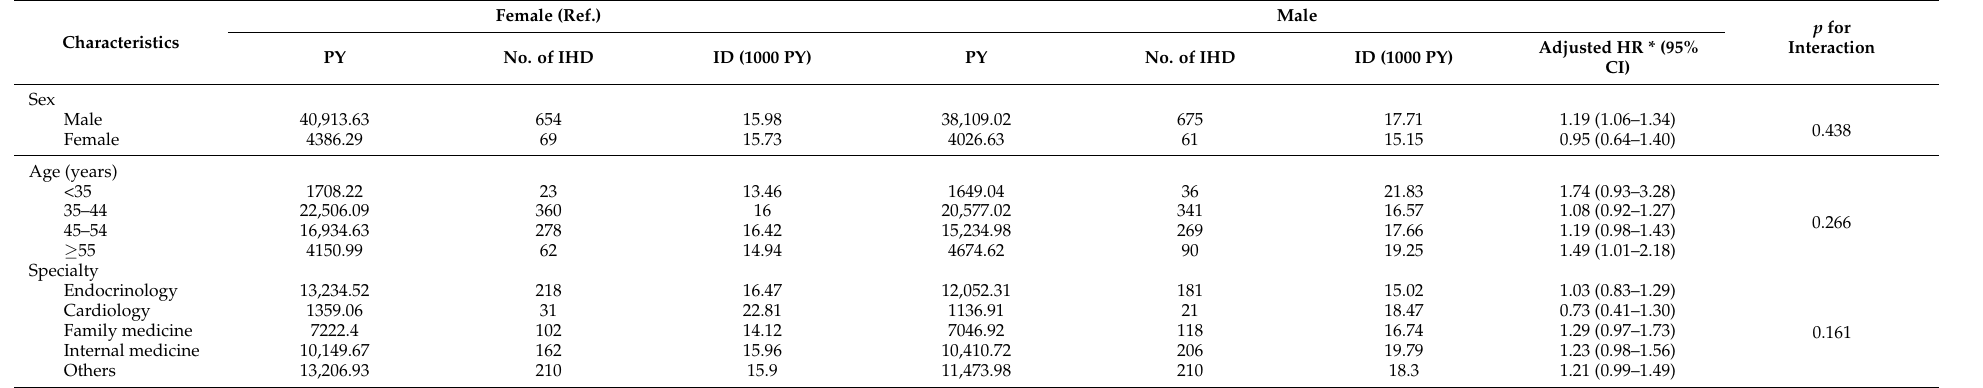
Table 3. Associations of sex with hazard ratios of ischemic heart disease according to physician